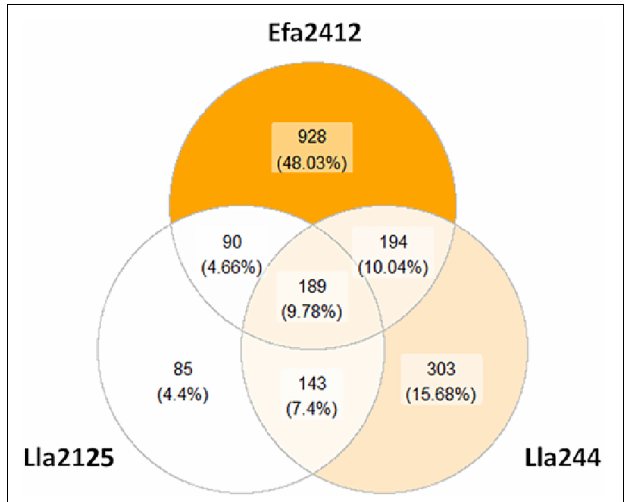
FIGURE 3 | Venn diagram of the peptides produced by the three donor strains throughout the 22 h of culture. The color scale is correlated with the number of peptides